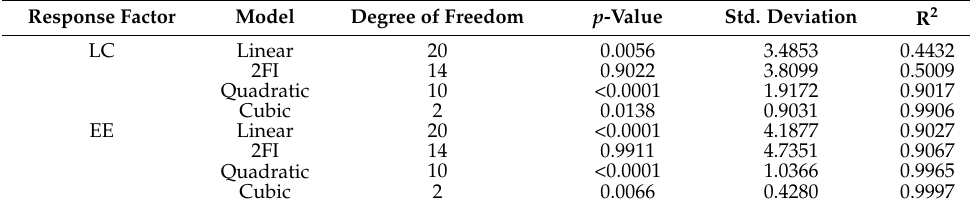
Table 2. Analysis of variances for the variables in preparation of the Pickering emulsion pertaining to response loading capacity (LC) and encapsulation efficiency